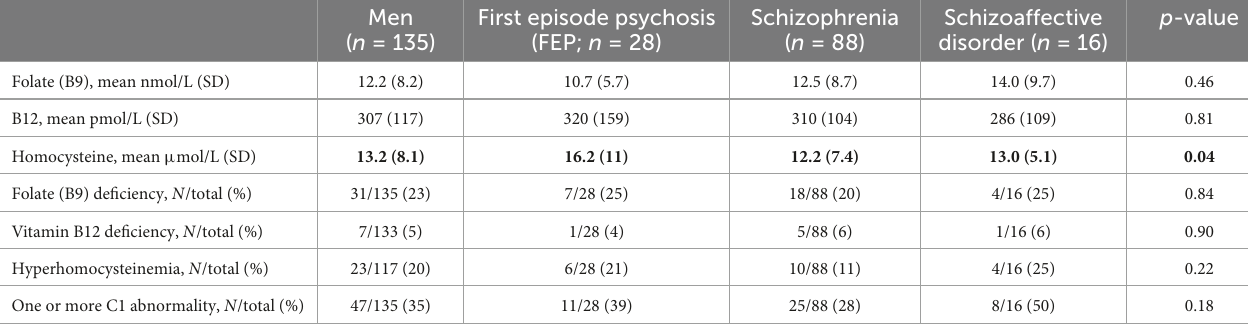
TABLE 3 Biological characteristics according to diagnosis in men.